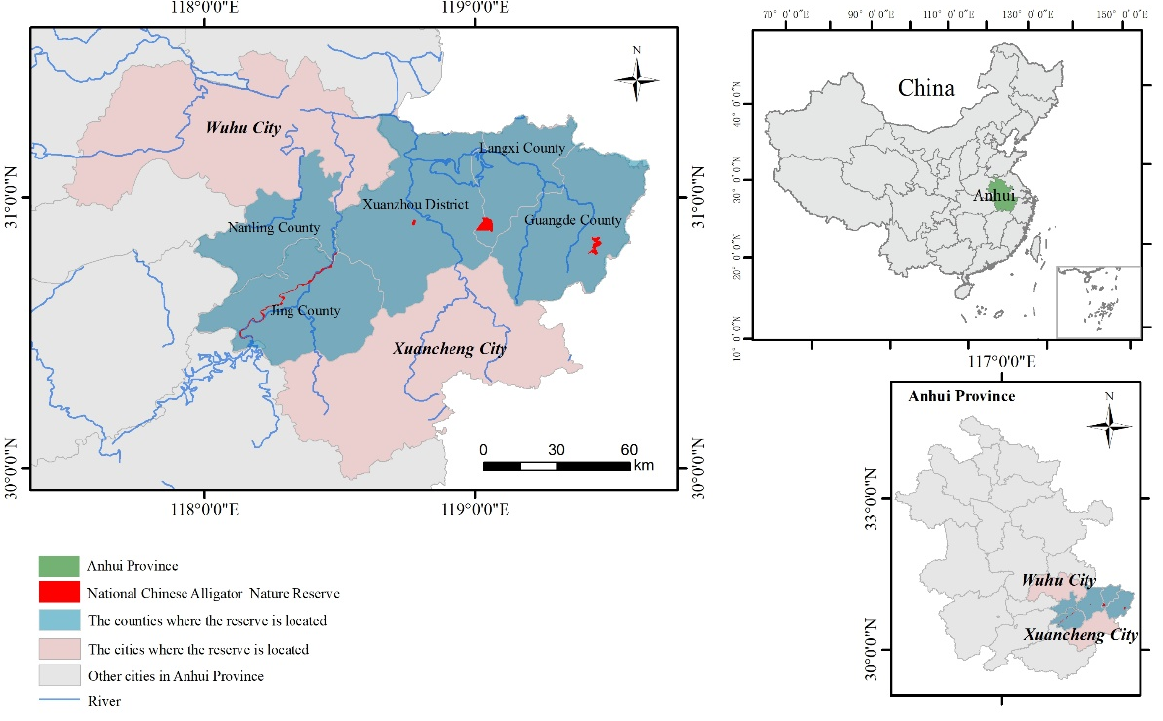
Figure 1. Location of the study area.